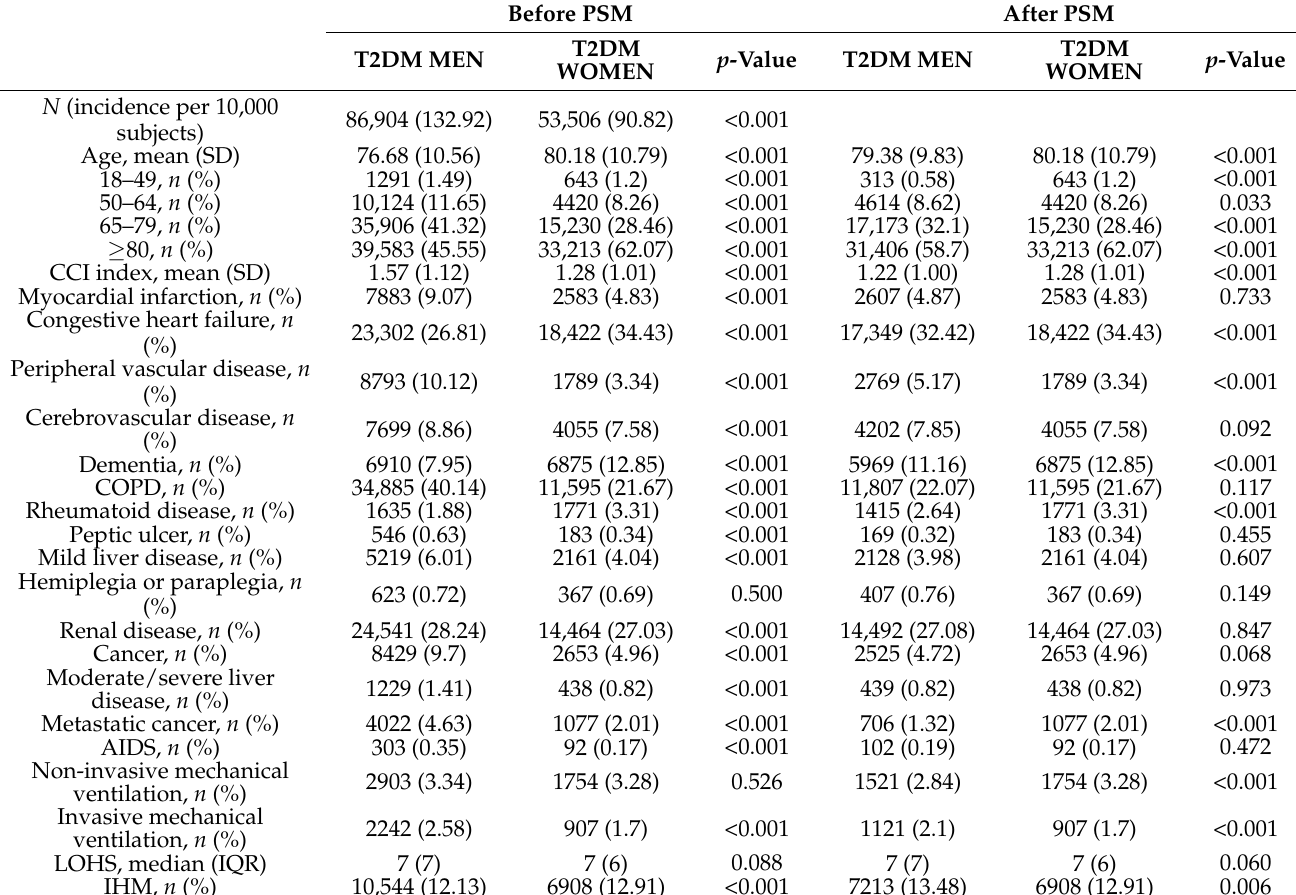
Table 4. Distribution of study covariates and hospital outcomes of men and women with T2DM hospitalized with community-acquired pneumonia (CAP) in Spain (2016–2019), before and after propensity score matching (PSM).